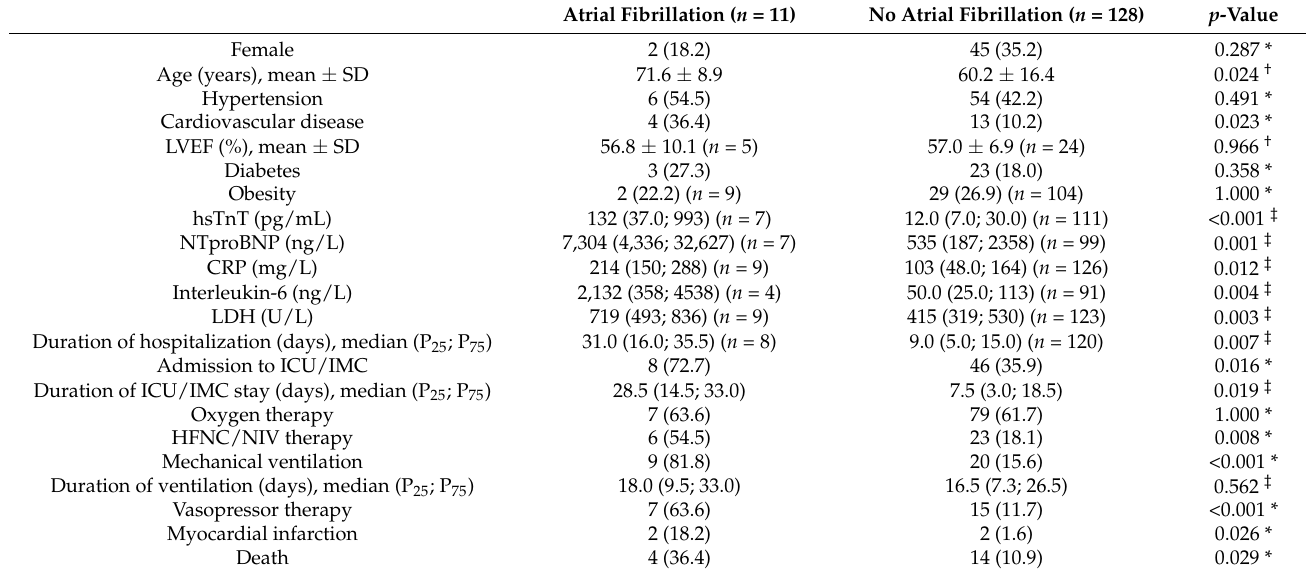
Table 5. Patients with incident atrial fibrillation in